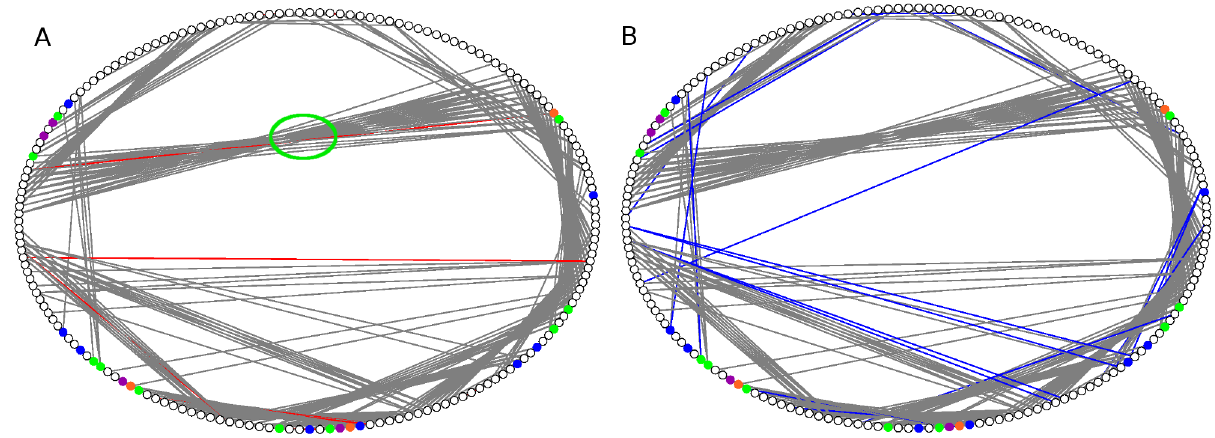
Figure 5. Ring Graph representation of contacts lost and made. Ring Graph representation showing A) the contacts lost (Red) and B) the contacts made (Blue) in the mutant 6B. The nodes are color-coded. Active Site residues have been shown in Green, Catalytic triad residues in Orange, Mutated residues in Blue, and Active site Mutated residues in Purple. The lost contacts have been shown in the PCN of WT.